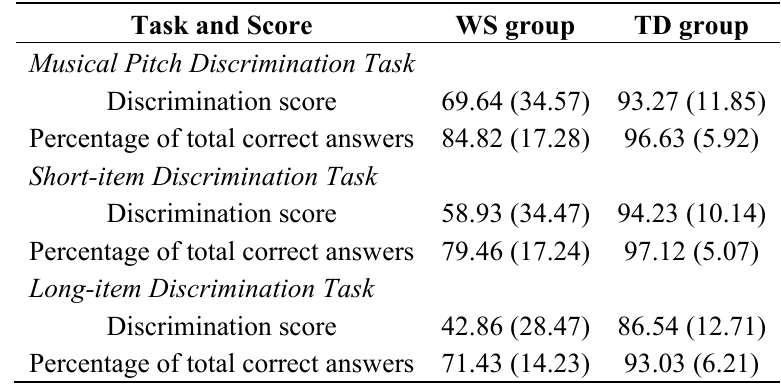
Table 2. Mean discrimination scores and percentages of total correct answers obtained in the music and prosody tasks used in the study. Values presented in parentheses represent standard